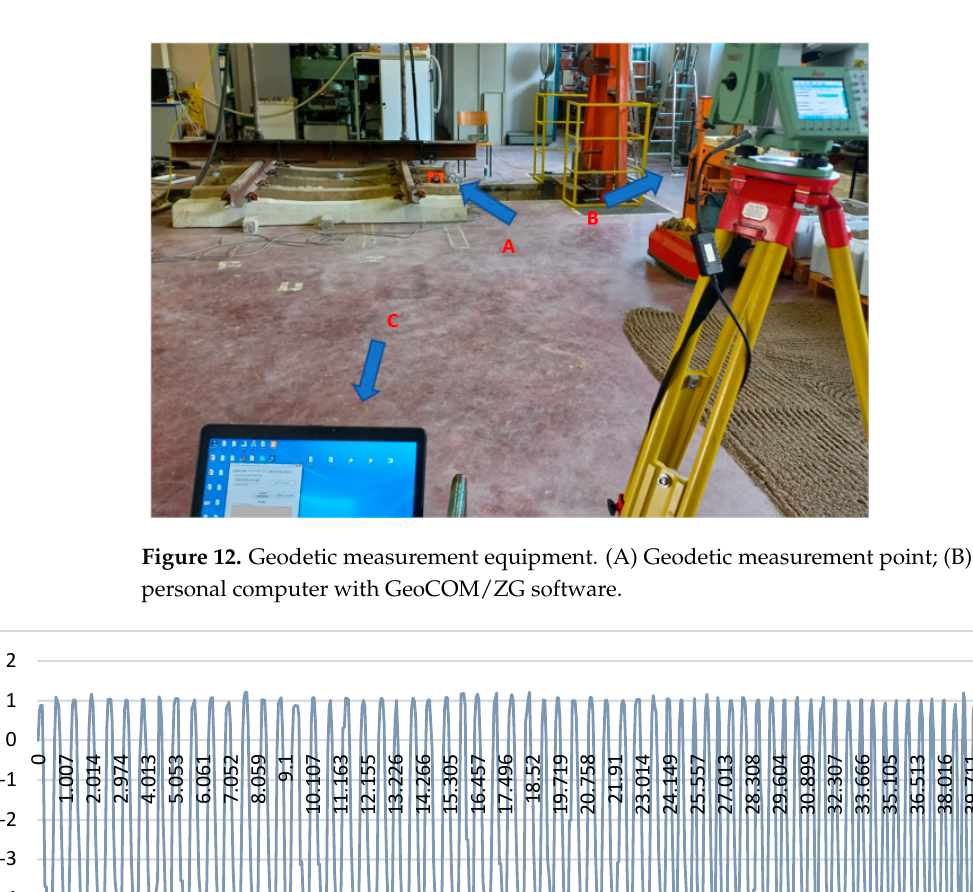
Figure 13. Plot of the vertical displacement measurement at the G3 (B) measuring point for an inter- val of 40 s; the maximum vertical displacement is 5.18 mm.